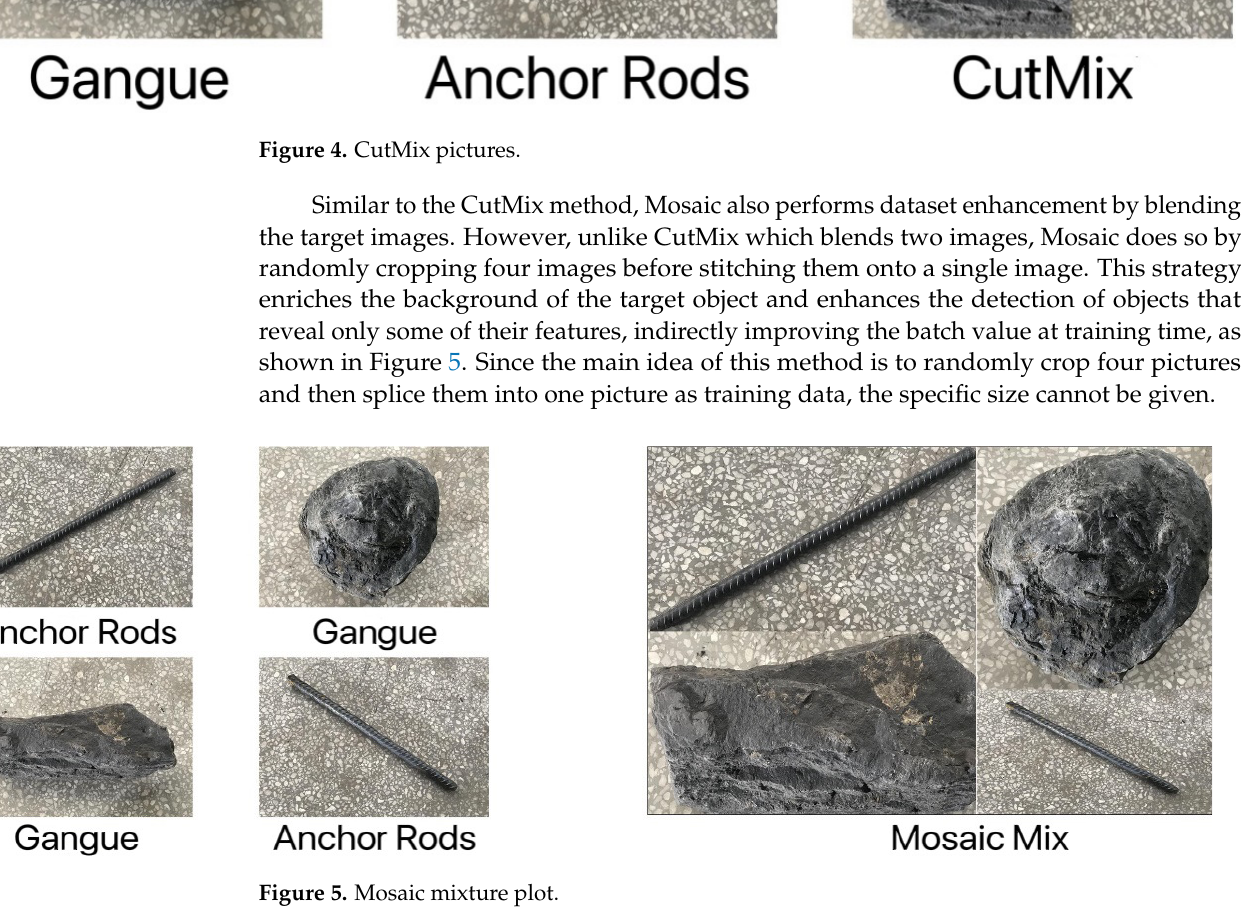
Figure 5. Mosaic mixture plot.